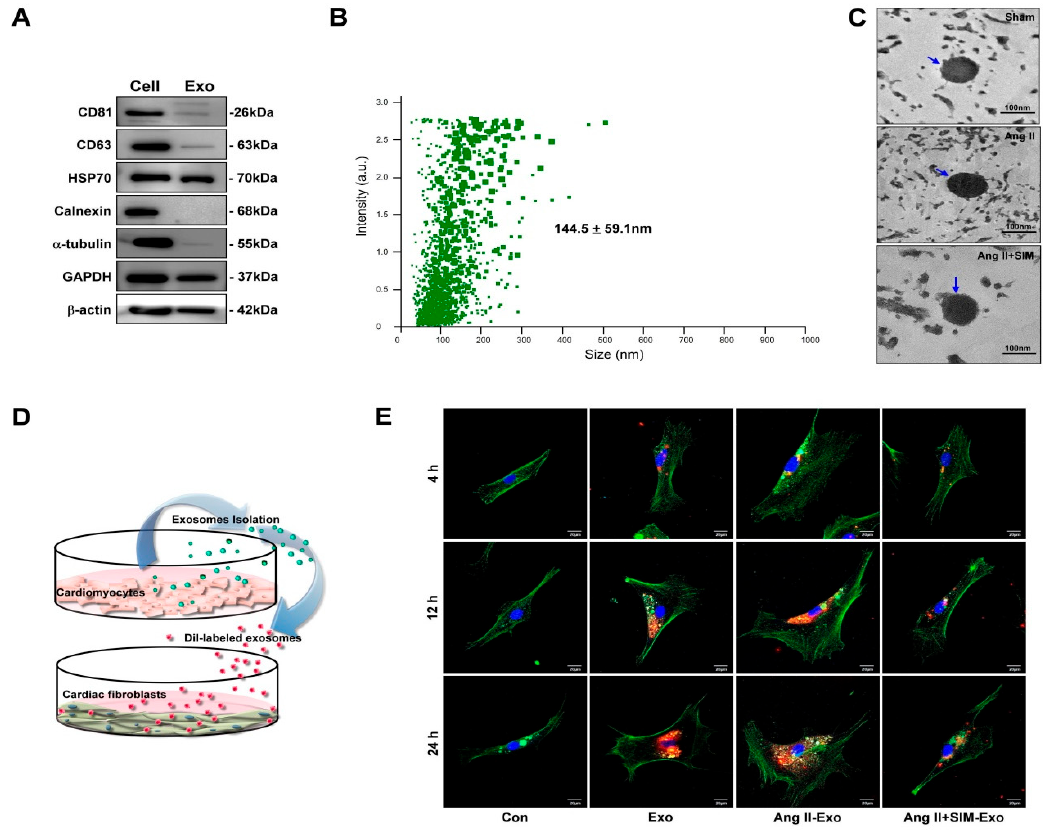
Figure 3. HCM-derived exosomes are transported into human cardiac fibroblasts (HCF) in vitro. Exosomal-specific marker expression from HCM-isolated exosomes was measured using Western blot analysis ( A ). HCM-isolated exosome size was demonstrated by NanoSight NS300 ( B ) and TEM analysis ( C ). To identify uptake of HCM-derived exosomes by HCF, exosomes were isolated from HCM-conditioned medium, after treatment with Ang II, or Ang II + SIM for 24 h. HCM exosomes were labeled with the DiI dye (5 µ g / mL, red florescence) for 1 h, and incubated with HCF cells for various times (4, 12, and 24 h) ( D ). HCF cells were non-treated (control), or treated with Eox, Ang II-Exo and Ang II-SIM-Exo for various times (4, 12, and 24 h), then stained for intracellular cytoskeleton F-actin (green florescence; nucleus, blue florescence), and analyzed by confocal microscopy ( E ). Scale bars: 20 µ m. Each image is representative of three independent experiments.